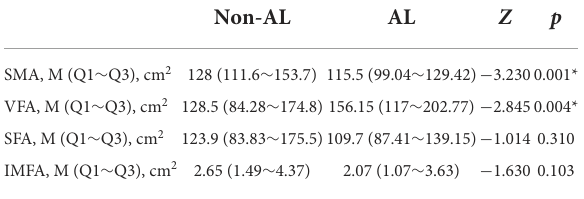
TABLE 2 Preoperative CT body composition of the